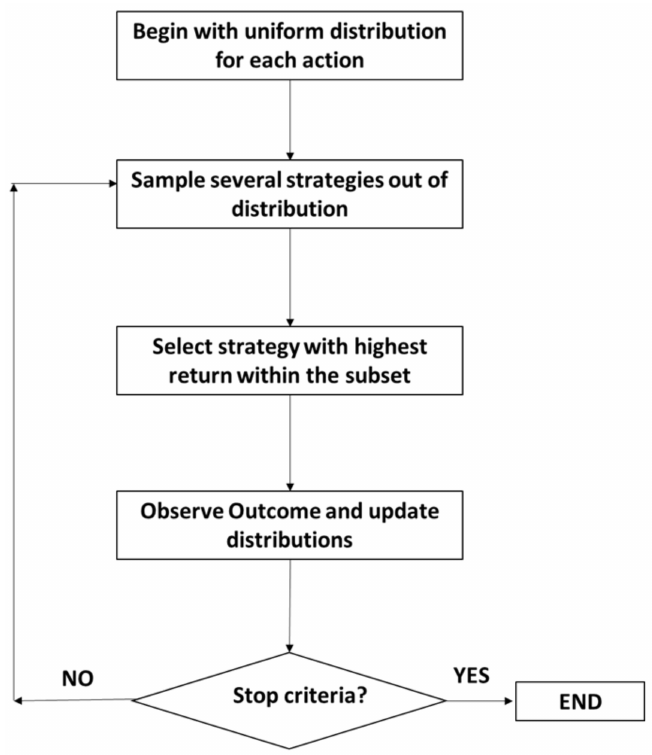
Figure 6. Algorithm process flow for posterior sampling.